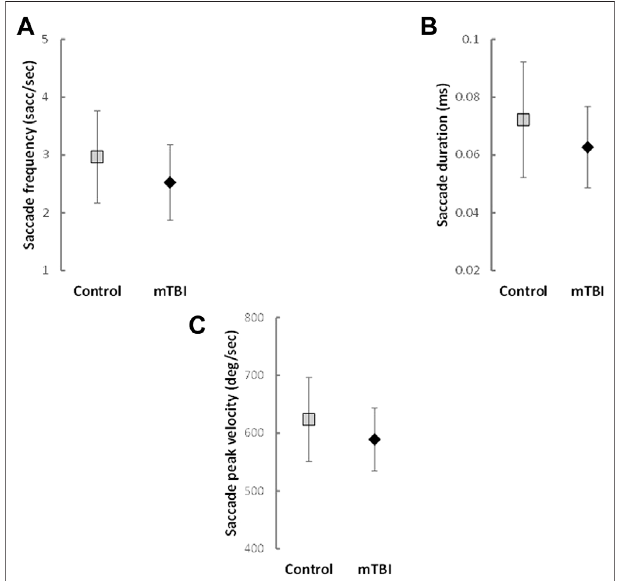
FIGURE 1 | Means and Standard Deviations of saccade outcomes with signi fi cant differences between groups.